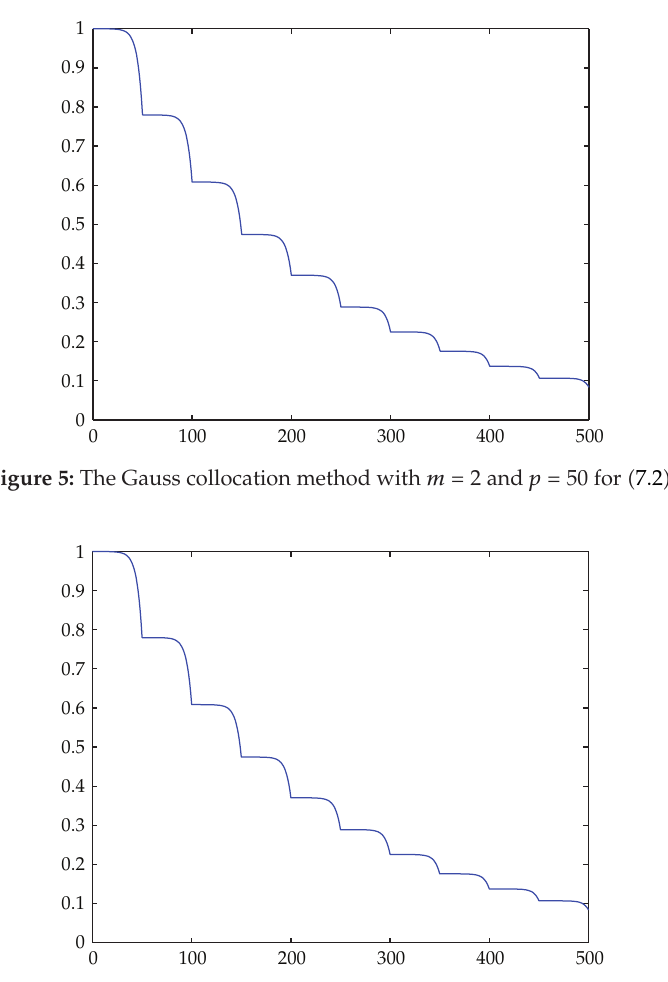
Figure 6: The Radau IIA collocation method with m (cid:4) 2 and p (cid:4) 1000 for (cid:2) 7.2 (cid:3)